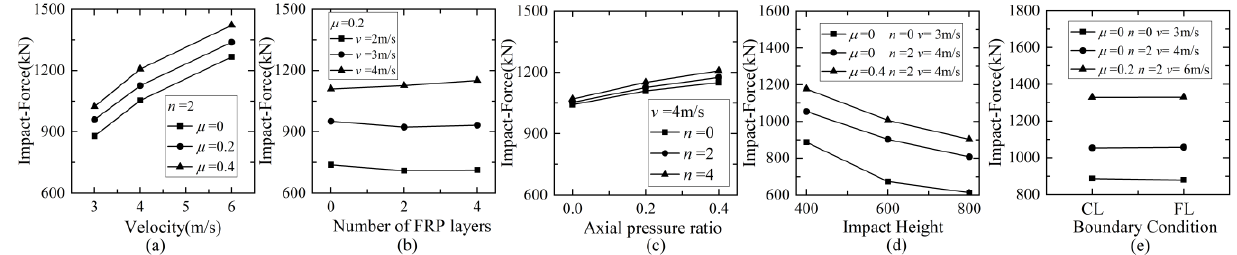
Figure 11. Maximum impact force versus: ( a ) impact velocity; ( b ) number of CFRP layers; ( c ) axial compression ratio; ( d ) impact height; ( e ) boundary condition.